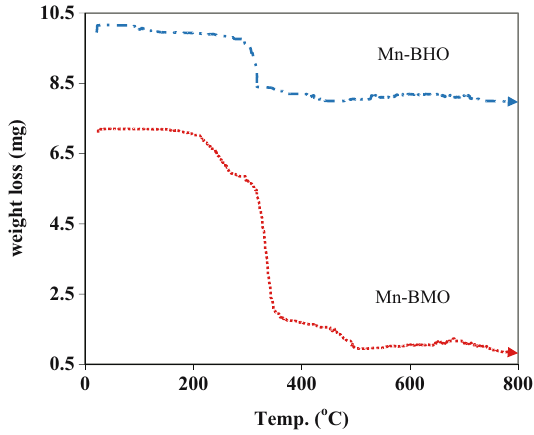
Figure 3: TG spectrum of manganese ( II ) complexes.